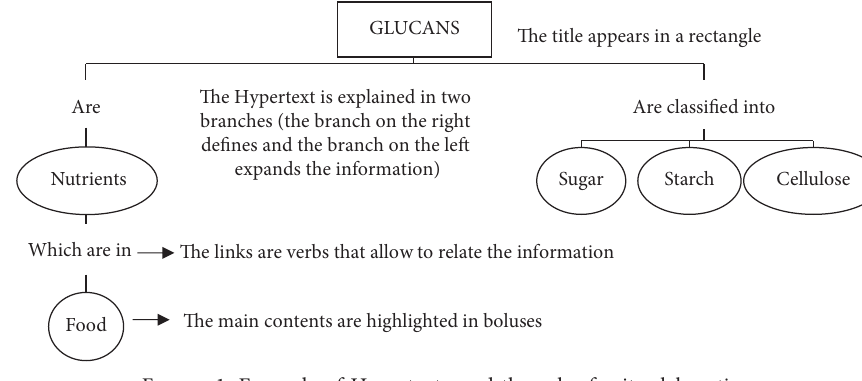
Figure 1: Example of Hypertexto and the rules for its